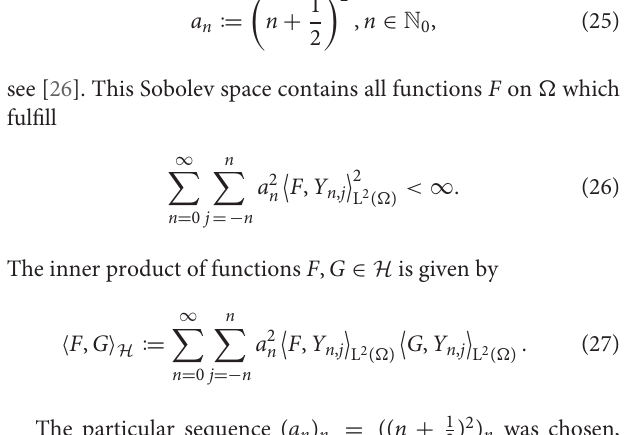
H 0 , a data vector y ⊂ \{ } R l (linear and continuous) be →